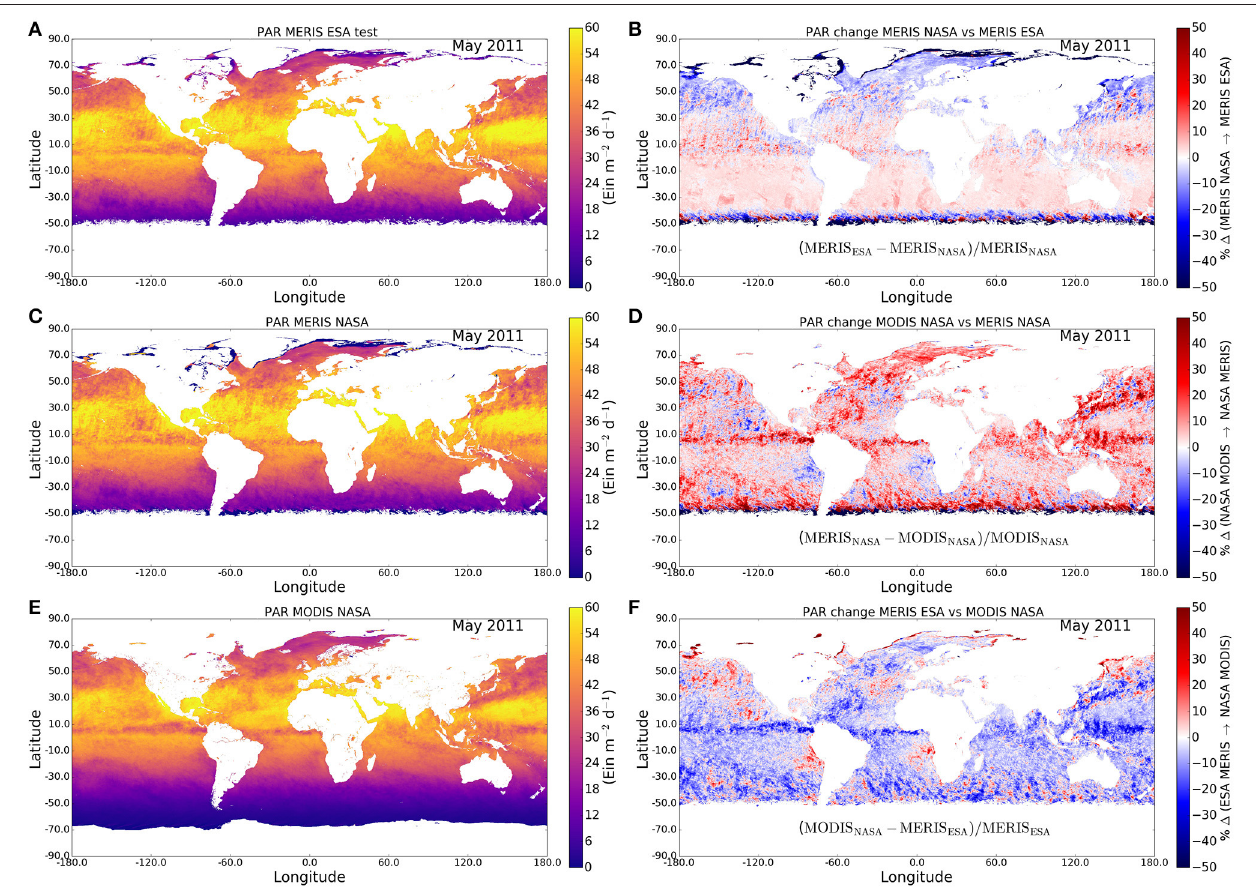
FIGURE 5 | Systematic differences in surface PAR arising from choice of data stream, exemplified by difference between MERIS and MODIS streams for May 2011. (A) PAR field from MERIS using ESA protocol (test product); (C) PAR field from MERIS using NASA product; (E) PAR field from MODIS Aqua using NASA product; the differences between the products are shown in (B,D,F)